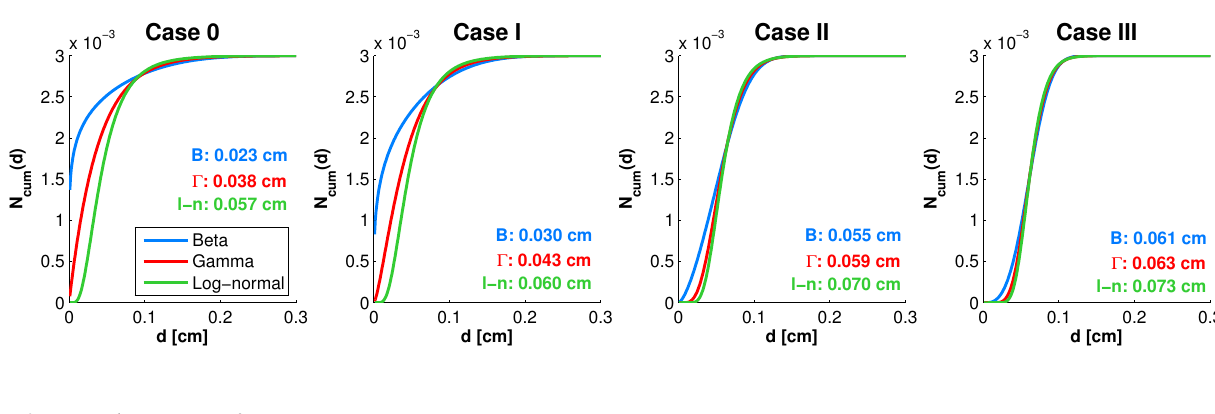
Figure 9. Cumulative number density function (19) of the three distribution functions for Cases 0–III (see Table 5). The inset numbers give the mean diameter of the